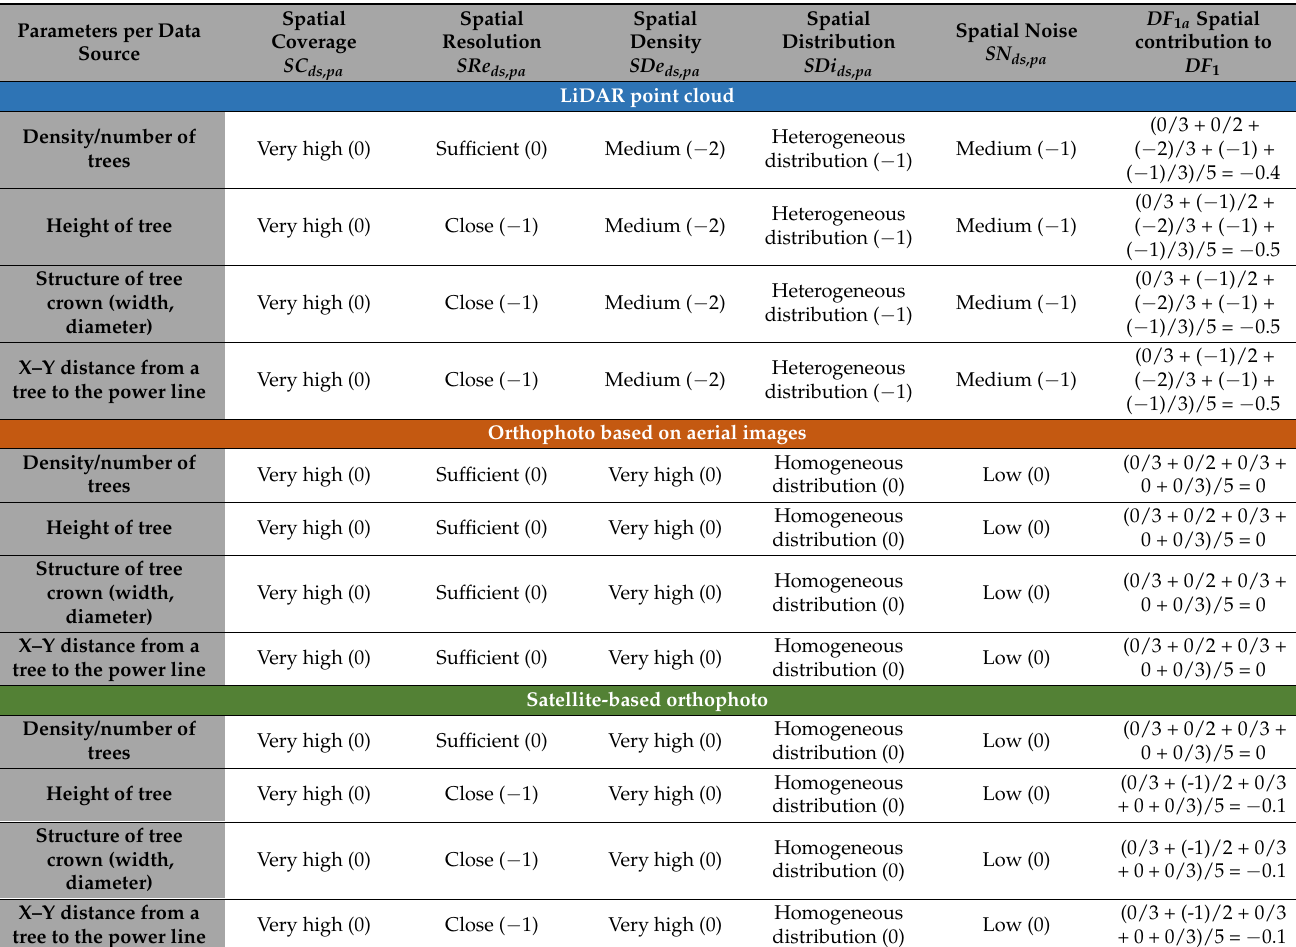
Table 22. Meta-features phase 2—spatial contribution to DF 1 per data source per parameter.